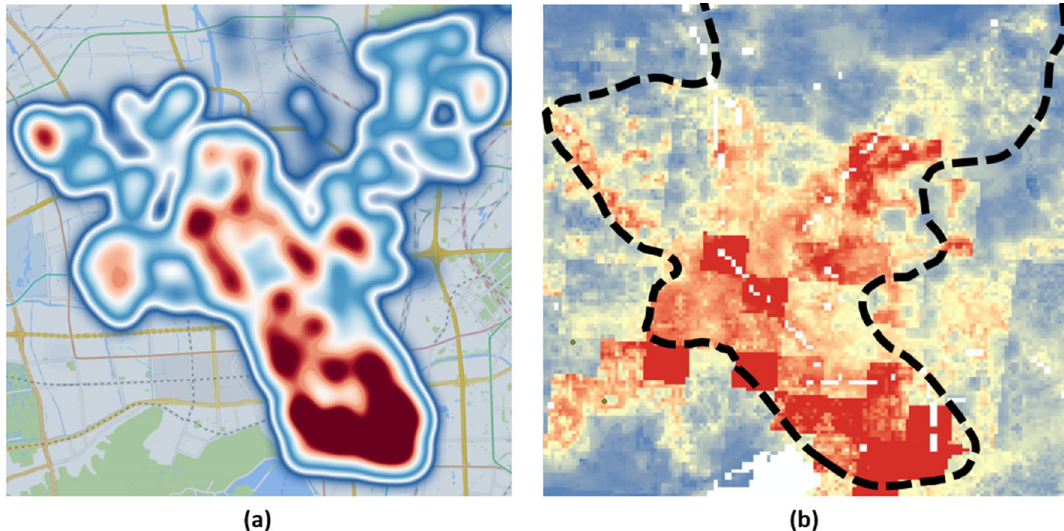
Figure 5. Comparing the starting point of our results with high-precision population density dataset published by Worldpop. ( a ) is the heat map based on the starting point of the trajectory we generated (created by Gaode Map JS API, version 2.0, https:// lbs. amap. com/ api/ jsapi- v2/ summa ry). ( b ) is the heat map based on the population density dataset published by Worldpop. We have marked the area we generated with black dashed lines